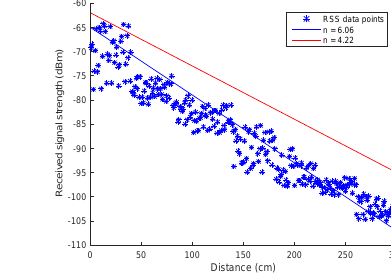
Figure 5: Probability density of RSSI(CM 1 and CM 2 combined)